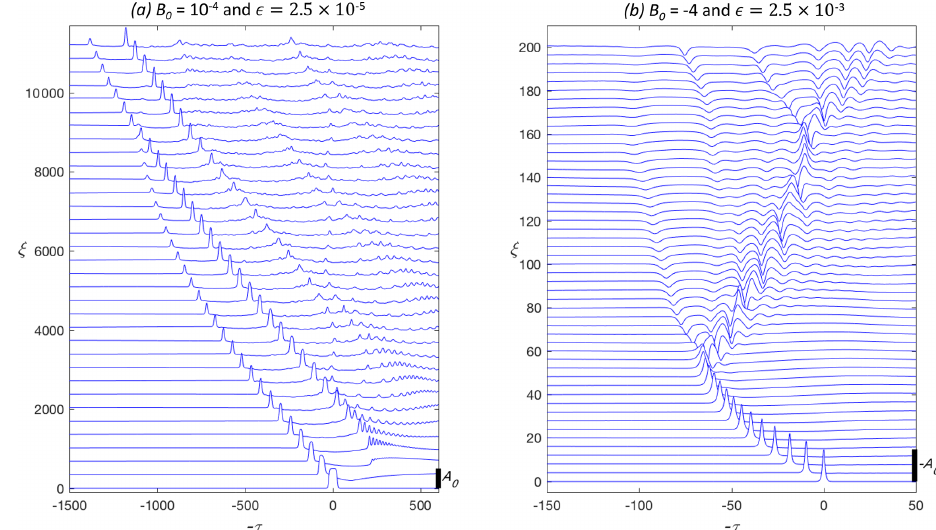
Figure 4. Numerical solution of Eq. (30) with (a) (cid:15) = 2 . 5 × 10 − 5 and B 0 = 10 − 4 and (b) (cid:15) = 2 . 5 × 10 − 3 and B 0 = − 4. The solid bar indicates the initial wave amplitude A 0 = sgn (ν)(B 0 − 1 ) . Only a portion of the full ξ domain is shown. The locations of each time series are indicated by the vertical axis.